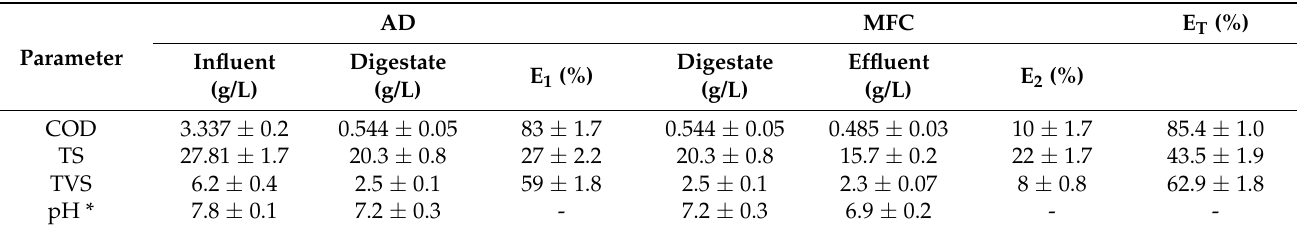
Table 4. Organic matter removal efficiency by AD and